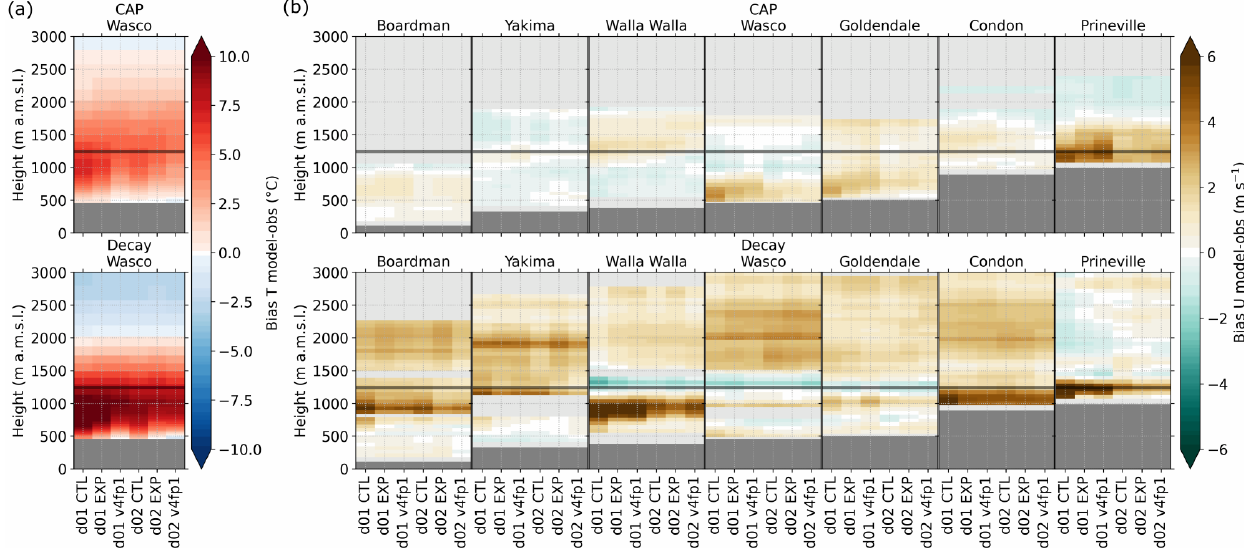
Figure 3. Profiles of mean temperature ( T ) bias (a) and horizontal wind speed ( U ) bias (b) averaged over the CAP and Decay periods for EXP, CTL, and v4fp1 at different locations in the Columbia River basin. The horizontal gray line indicates the mean ridge height, dark gray shading indicates the station height, and light gray shading indicates missing data.